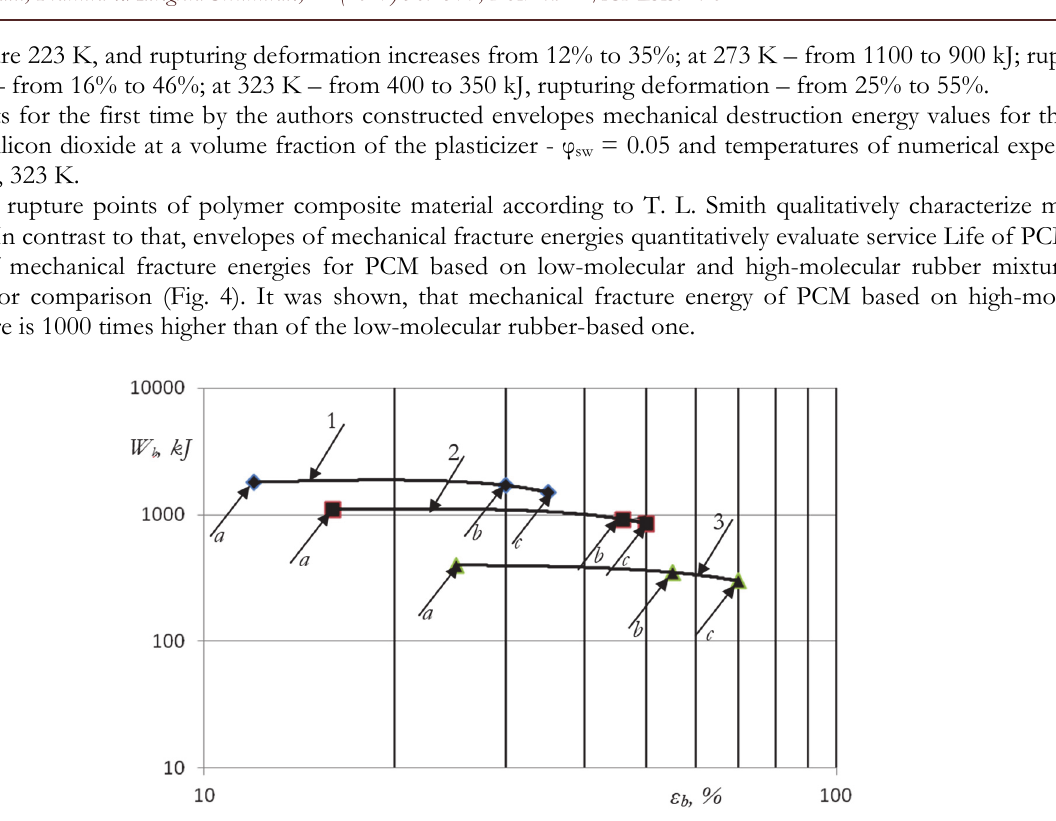
Figure 3: Envelopes of mechanical fracture energies. φ sw = 0.05; vol. fraction; Experiment temperature : 1 – 223 К ; 2 – 273 К ; 3 – 273